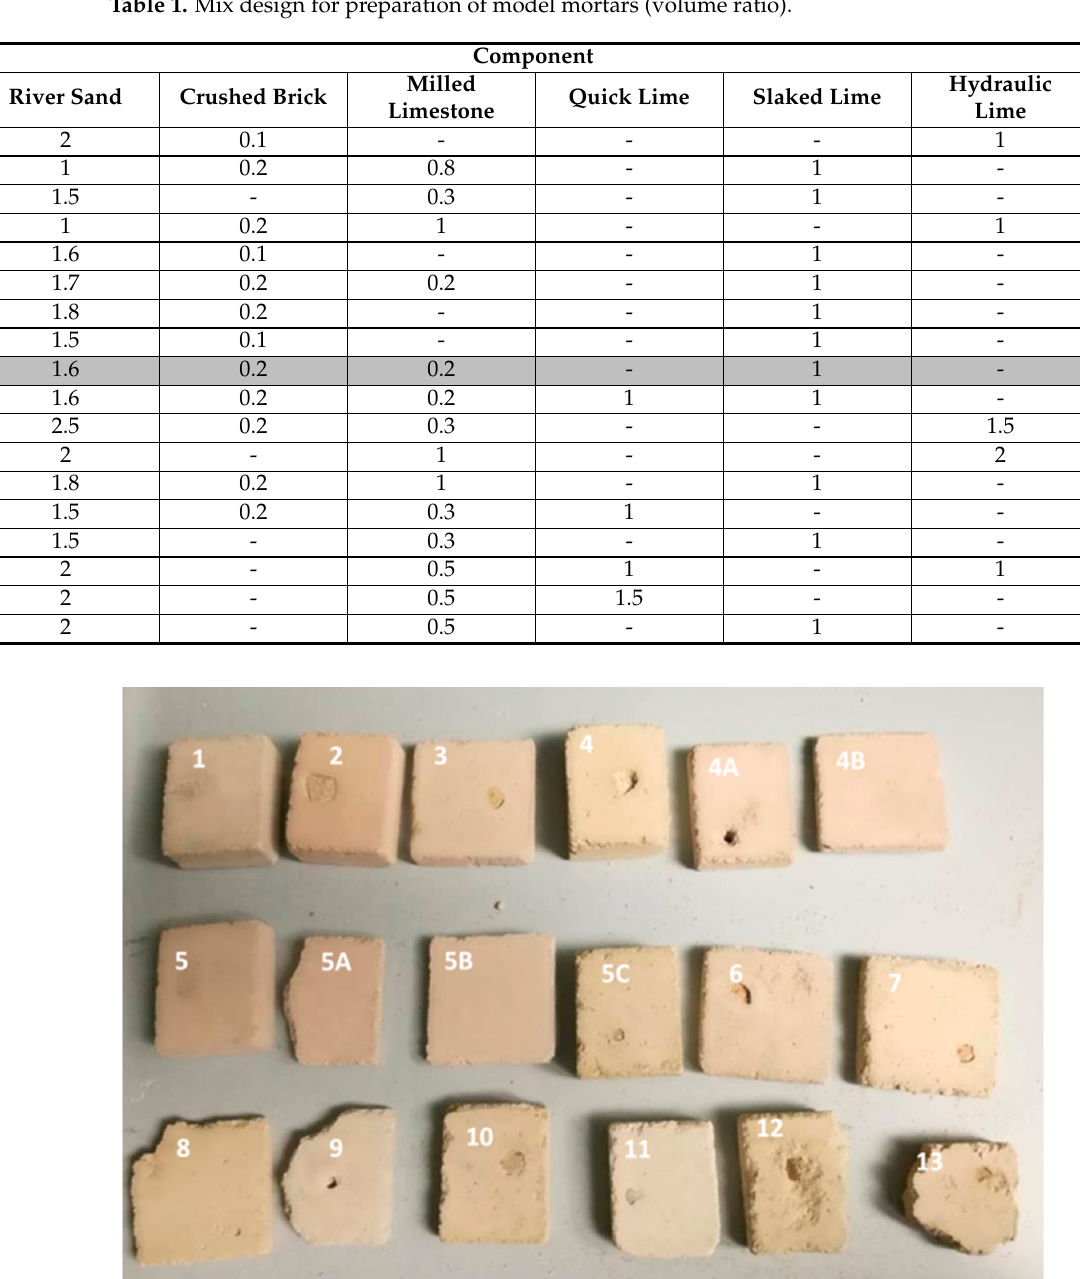
Table 1. Mix design for preparation of model mortars (volume ratio).